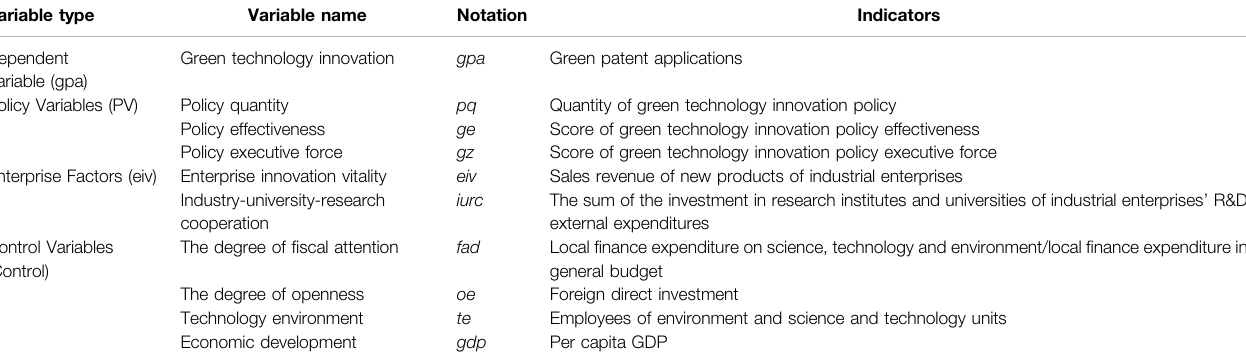
TABLE 2 | Variables description.